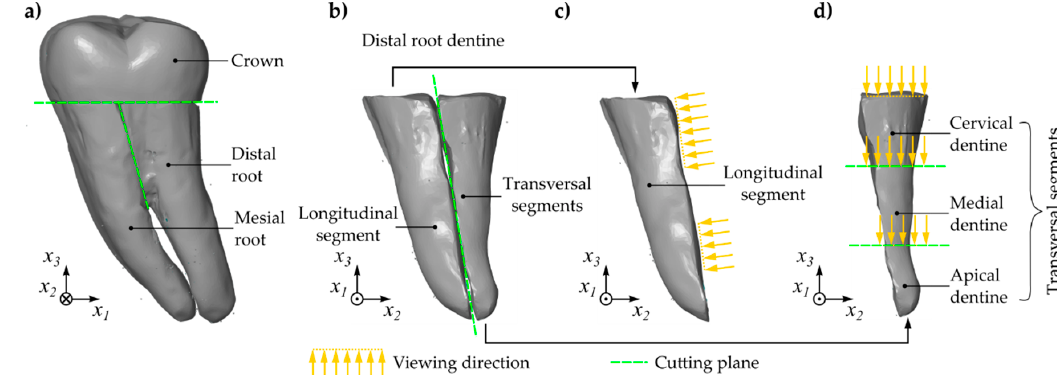
Figure 1. Sample preparation of human molar: separation of crown (lingual view), ( a ); partition of root dentin (distal view), ( b ); longitudinal segment (distal view), ( c ); partition of distal half (distal view), ( d ).